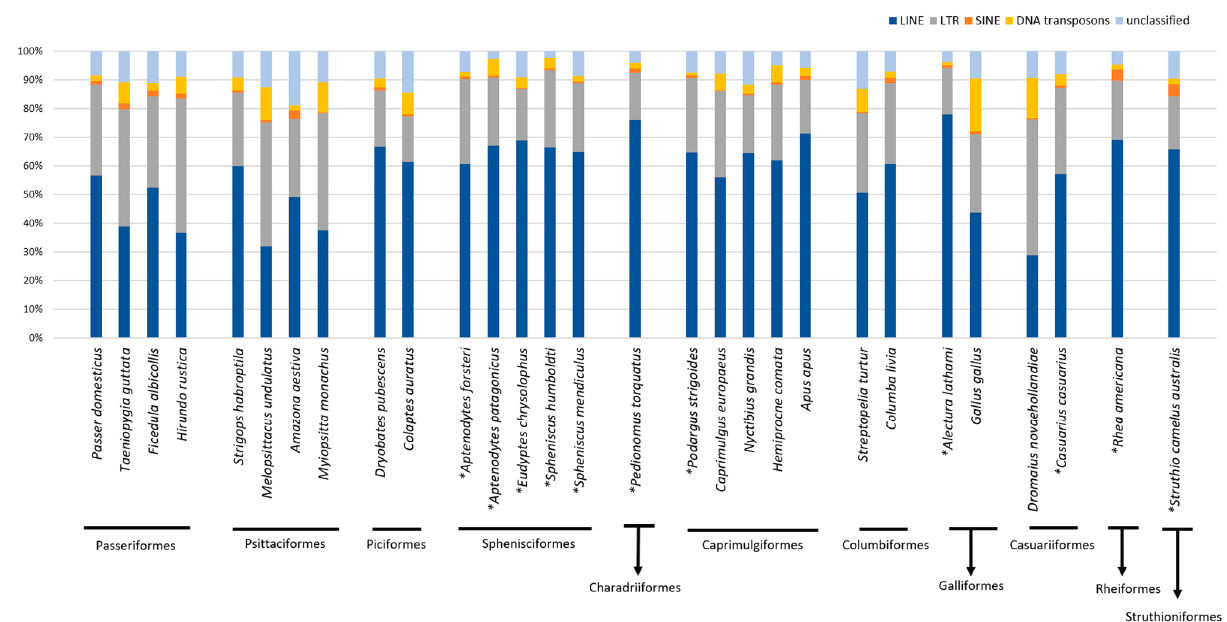
Figure 3. Relative abundance of TE types in the mobilome of the bird species analyzed. * indicates species for which the analysis was performed on scaffold-level genome assembly.